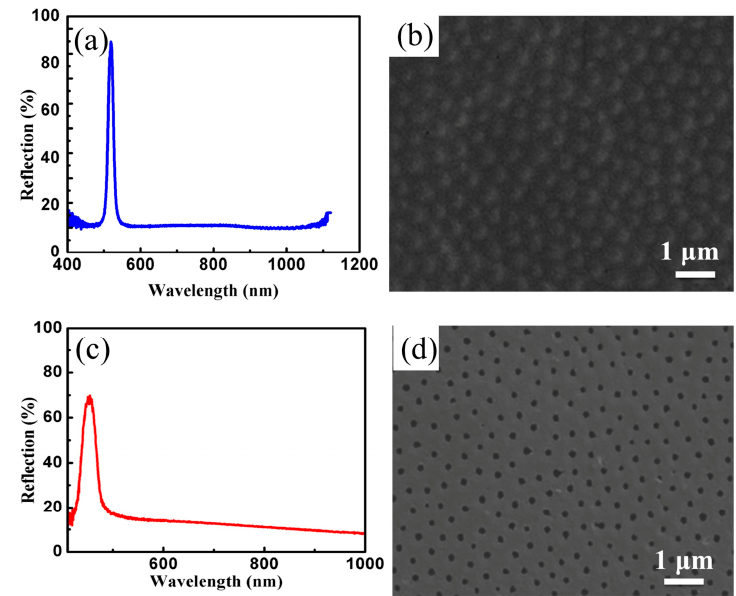
Figure 7. ( a ) Reflection spectrum of non-closed-packed opal structure PCs; ( b ) SEM image of non-closed-packed opal structure PCs; ( c ) Reflection spectrum of non-closed-packed inverse opal structure PCs; ( d ) SEM image of non-closed-packed inverse opal structure PCs.